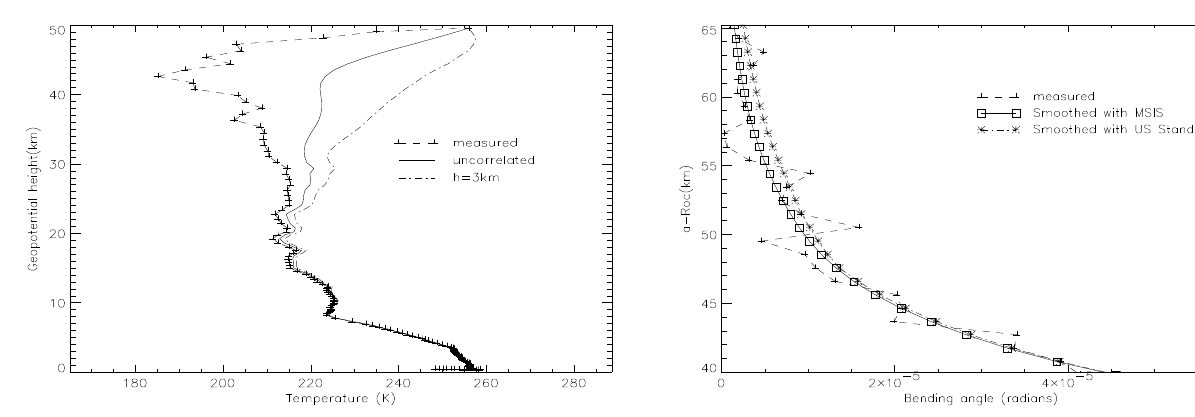
Fig. 9. The sensitivity of the temperature retrievals assuming an observation error correlation length of 3 km, using the ‘95-07-01- 02:44met-gps15’ measurement.